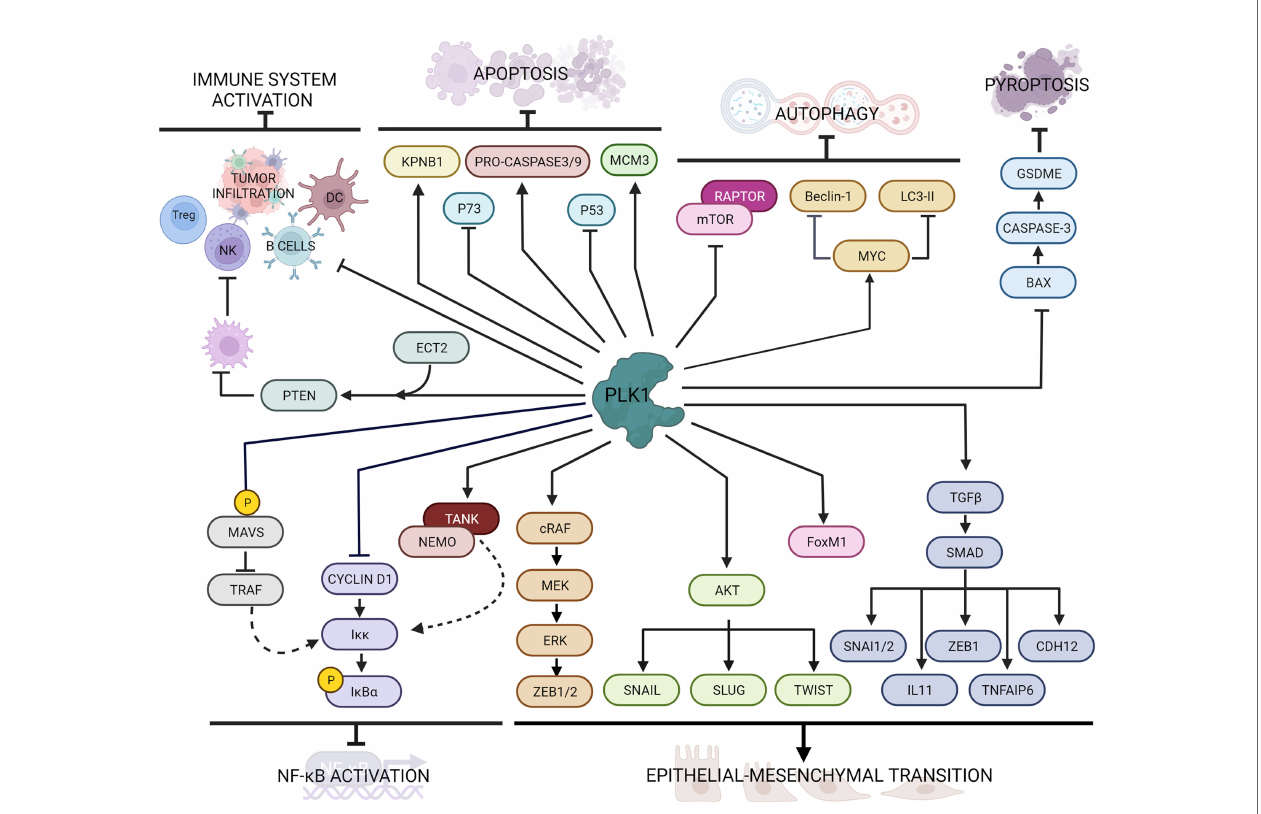
FIGURE 2 | Main PLK1 functions in cellular processes beyond mitosis and DNA damage response. PLK1 interacts with several intracellular factors regulating cell death pathways (i.e. apoptosis, autophagy and pyroptosis), immune response, in fl ammation and epithelial to mesenchymal